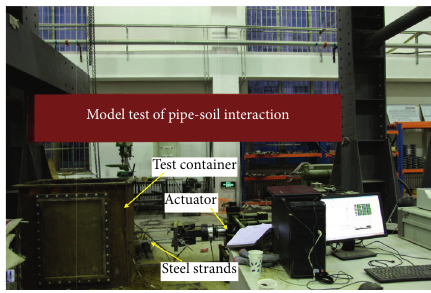
Figure 2: Model test